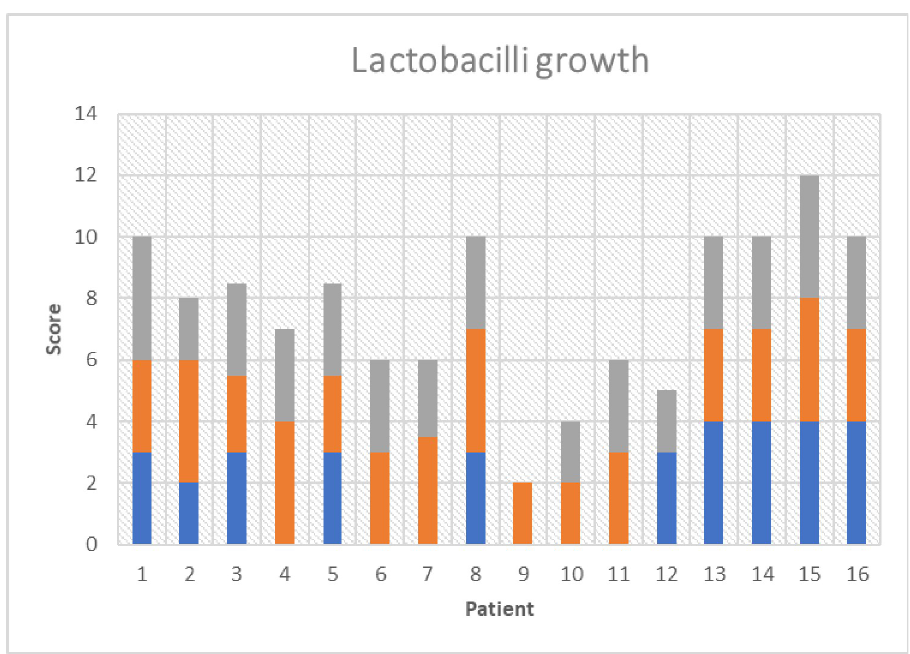
Fig 1. Lactobacilli growth score at time 0 (blue bars), just prior to MC consumption, time 1 (orange bars), one week after MC consumption, and time 2 (grey bars), four weeks after starting MC consumption.